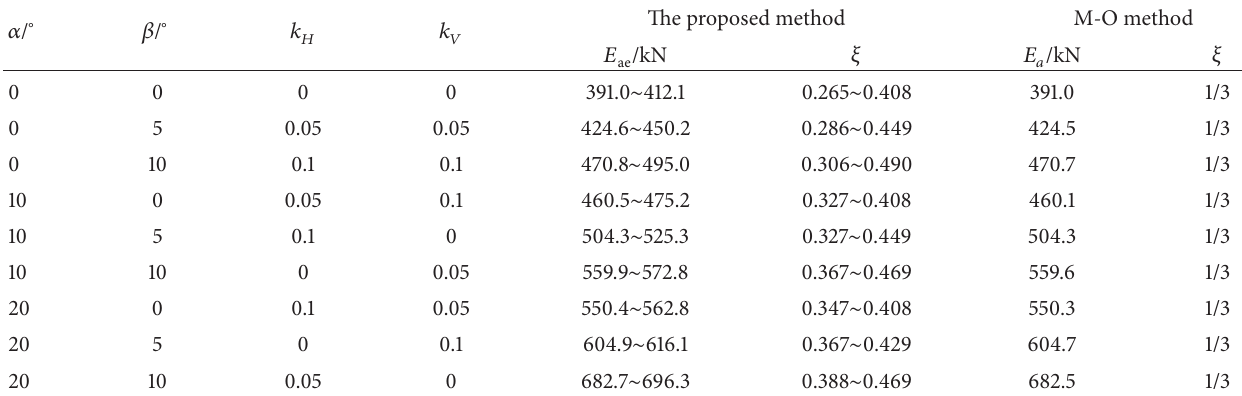
Table 1: Comparison of calculated results of active earth pressure with that of M-O.